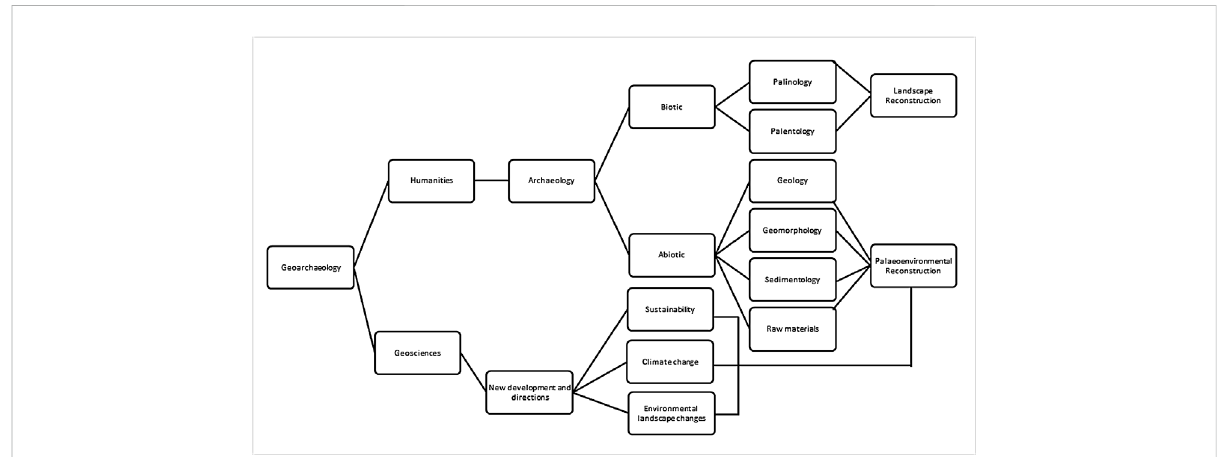
FIGURE 1 Interdisciplinarity in geoarchaeology.